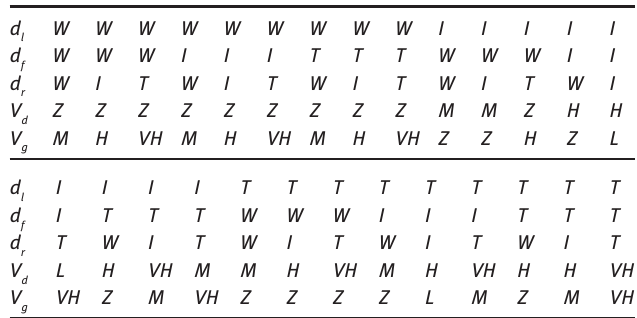
Figure 6: Output Speed Values. Table 1: Fuzzy Inference Table of the Speed of the Right and Left